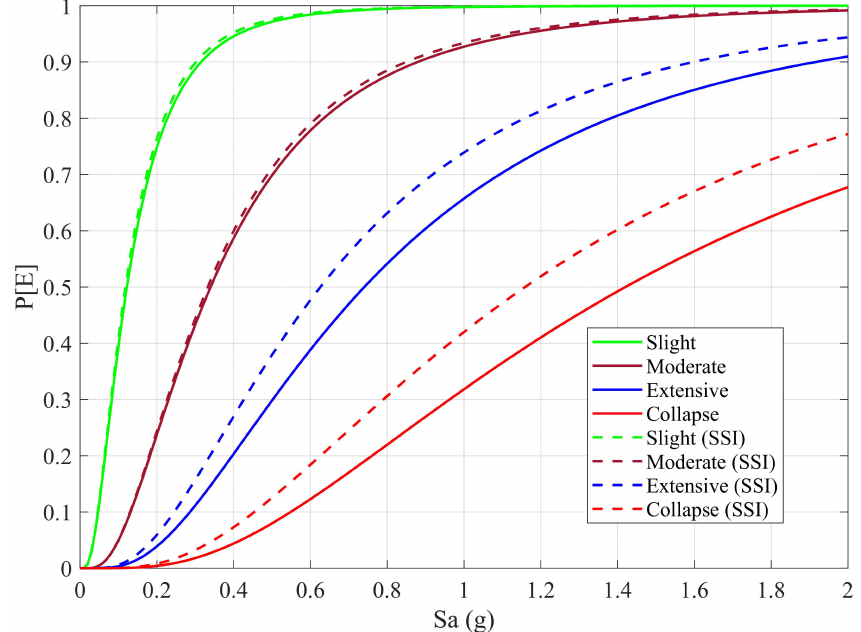
Figure 7. Fragility functions for RC elevated water tanks with smooth bars with and without considering soil structure interaction for half reservoir condition.